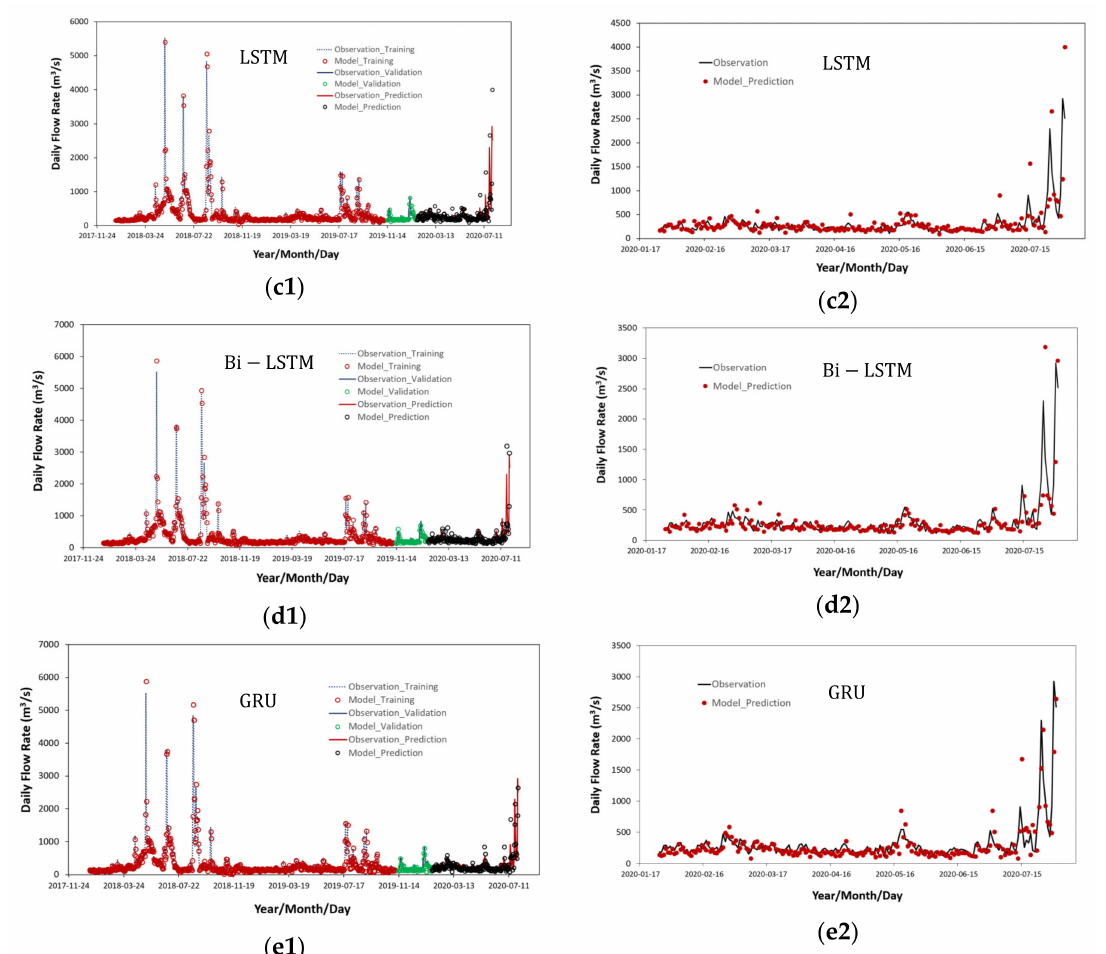
Figure 8. Observed and computed total time series flow rates ( a1 )–( e1 ) and prediction ( a2 )–( e2 ): ( a1 ) and ( a2 ) convolutional neural network (CNN); ( b1 ) and ( b2 ) simple recurrent neural network (RNN); ( c1 ) and ( c2 ) LSTM; ( d1 ) and ( d2 ) Bi-LSTM; and ( e1 ) and ( e2 ) gated recurrent unit (GRU).